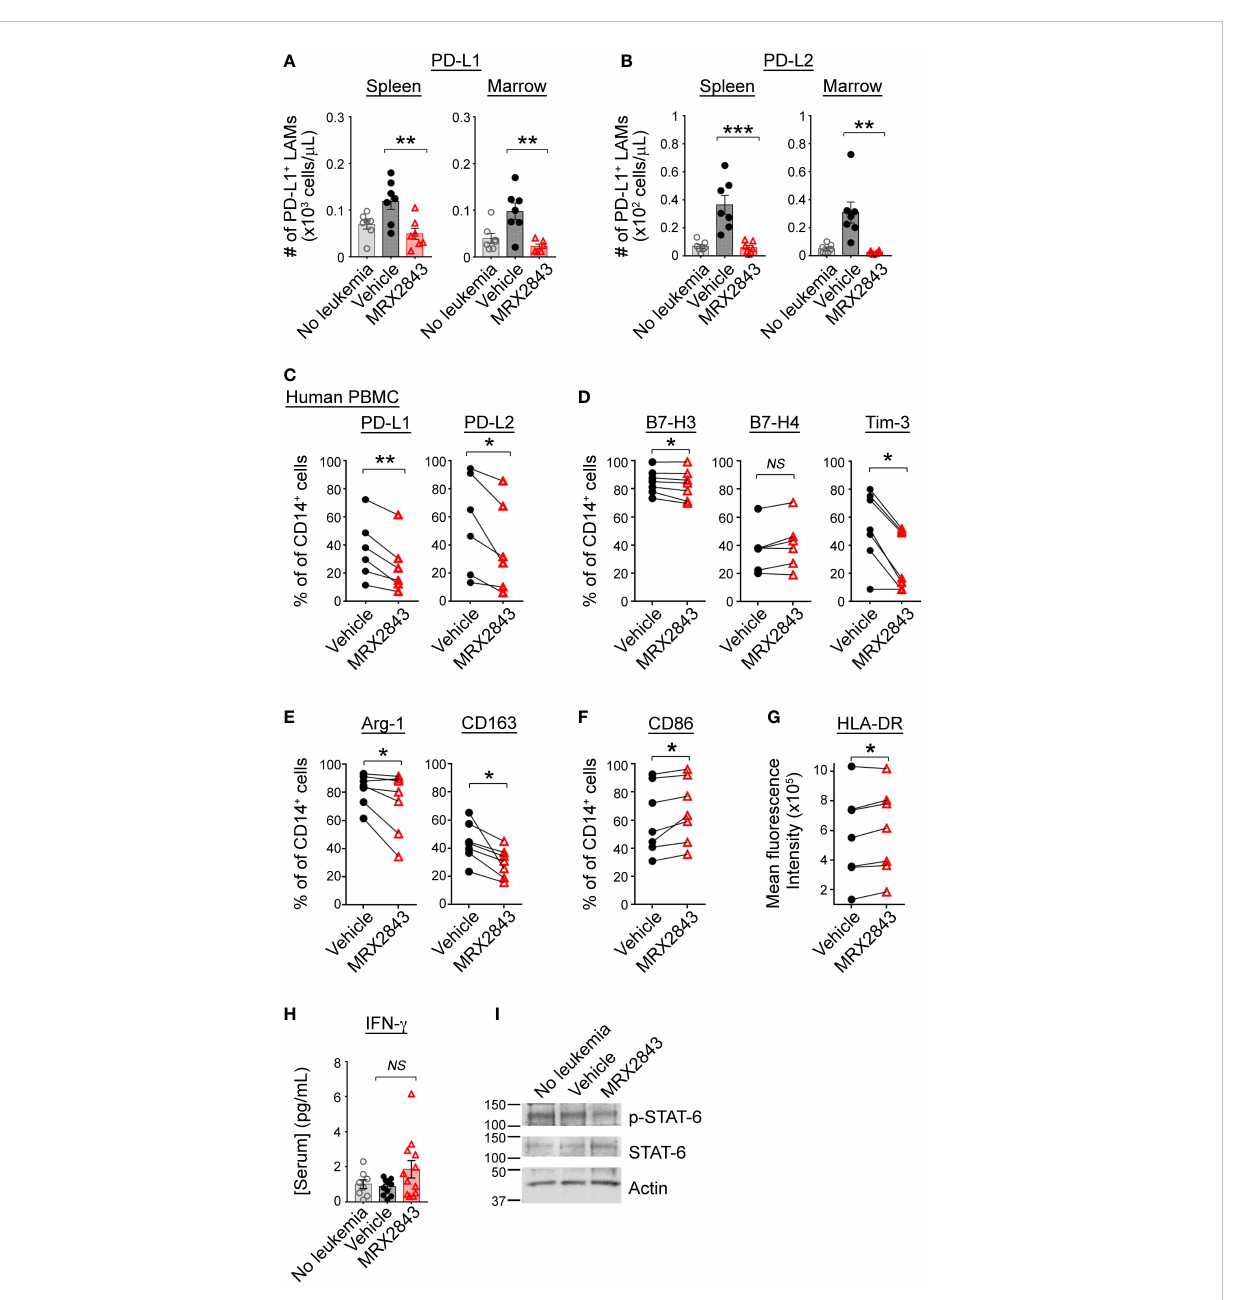
MerTK inhibition alters NF- k B activation Given the increased levels of IL-18 and IL-1 b with MRX2843- treatment, we evaluated for components of the in fl ammasome in